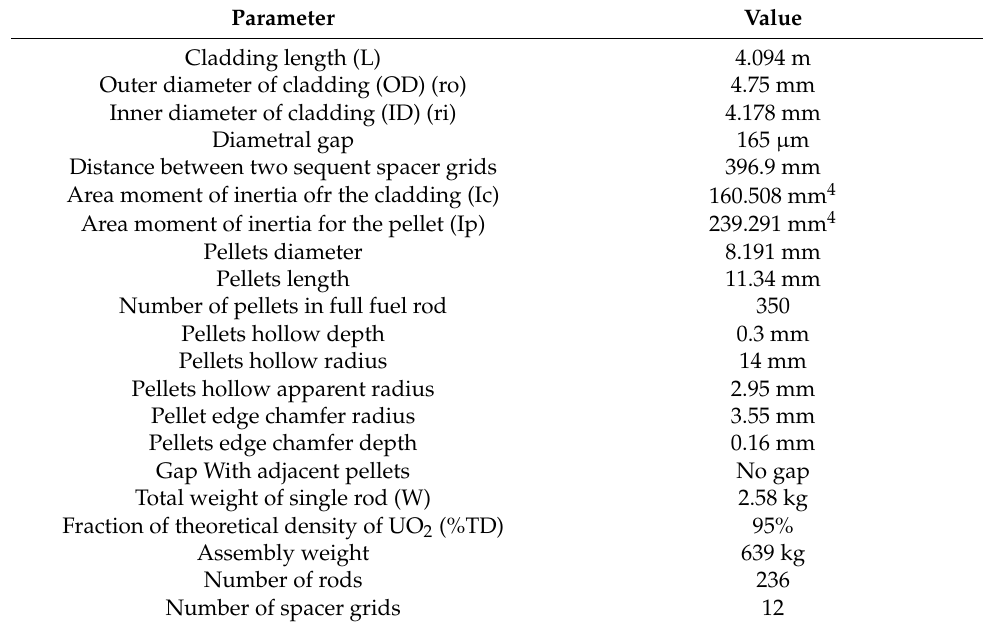
Figure 1. CE 16 × 16 fuel assembly design feature of the PLUS7. Reprinted with permission from ref. [15]. Table 1. Specifications of the fuel rod and assembly considered. Reprinted with permission from ref. [11].